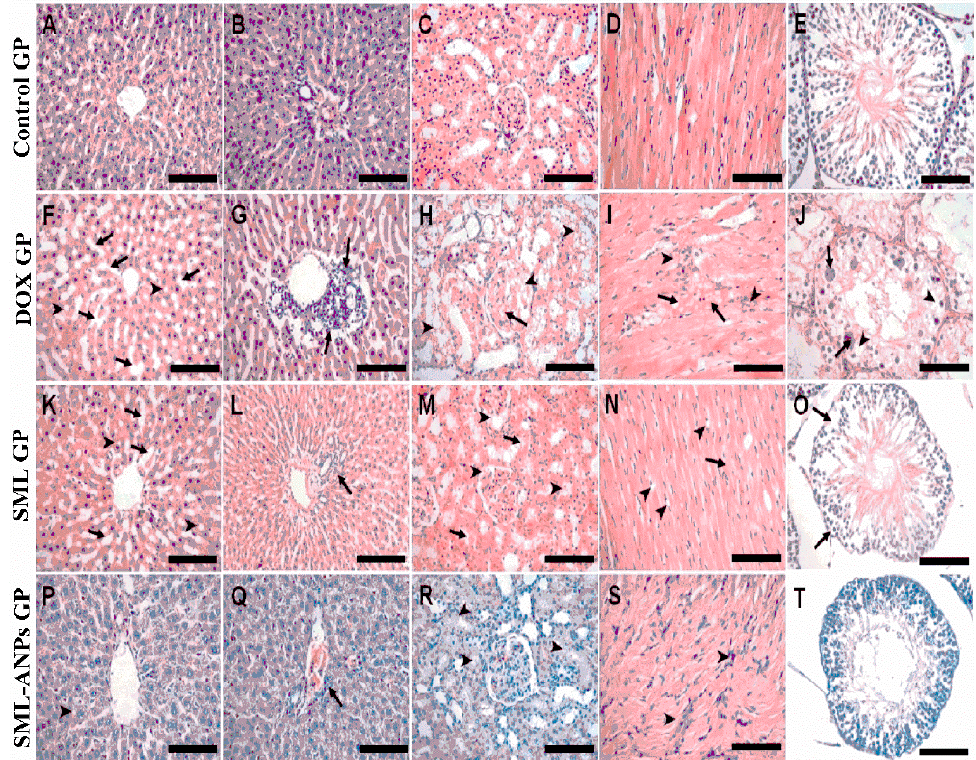
Figure 8. Histopathological changes of heart, liver, kidney, and testes in the control group, doxorubicin treated group (DOX GP), sesamol treated group (SML GP), and sesamol-loaded albumin nanoparticles group (SML-ANPs GP). ( A – E ) represent photomicrographs of the liver, kidney, heart and testis sections, respectively, stained by H & E from the control group. ( F – J ) represent photomicrographs of the liver, kidney, heart and testis sections, respectively, stained by H & E from DOX GP. ( K – O ) represent photomicrographs of the liver, kidney, heart and testis sections, respectively, stained by H & E from SML GP while ( P – T ) represent photomicrographs of the liver, kidney, heart and testis sections, respectively, stained by H & E from SML-ANPs GP.